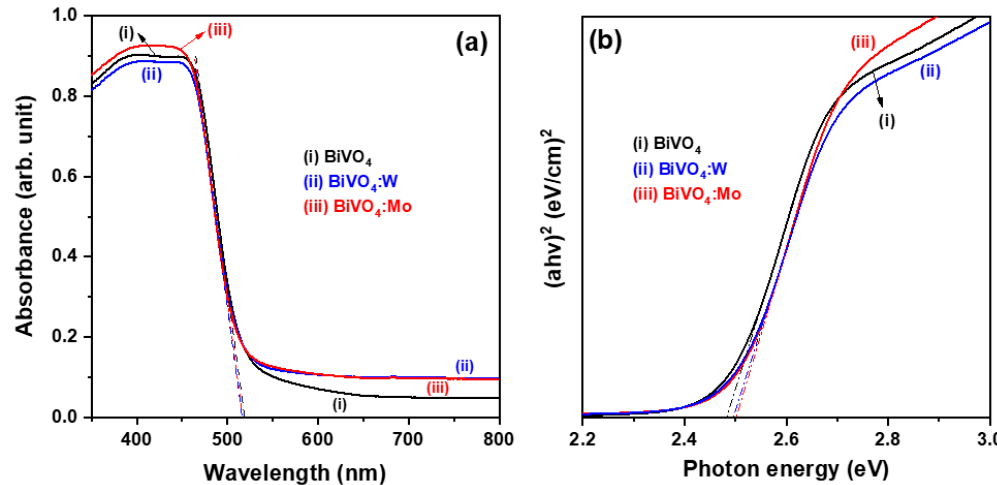
Figure 7. ( a ) UV-visible absorption spectra and ( b ) Tauc plots of three BiVO 4 -based powder samples. Figure 7b depicts the curves of absorption energy ( α h ν ) versus photon energy (h ν ), which were transferred from the recorded absorbance data. It was found that the absorption energy side (i.e., blue-shift behavior) relative to that of the undoped powder sample.